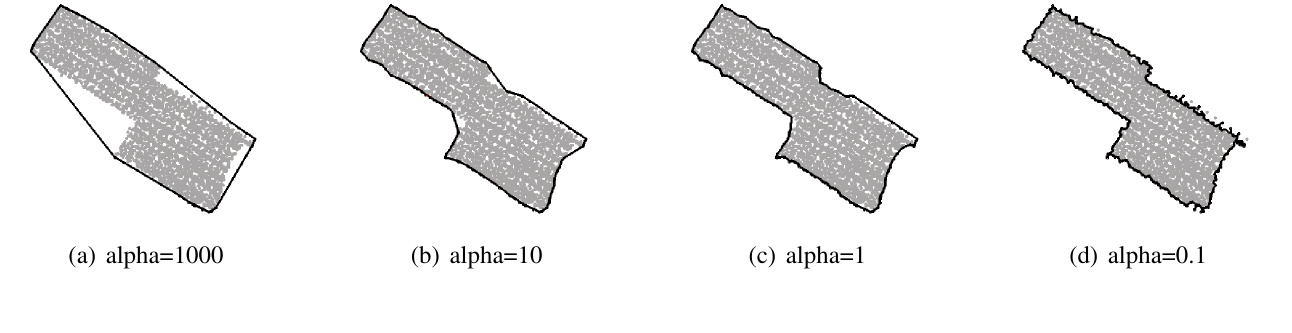
Figure 3. Segment boundary derived by alpha shapes for different values of α . For large values of α the convex hull is obtained (a), whereas small values lead to outlines with artifacts caused by the random point distribution